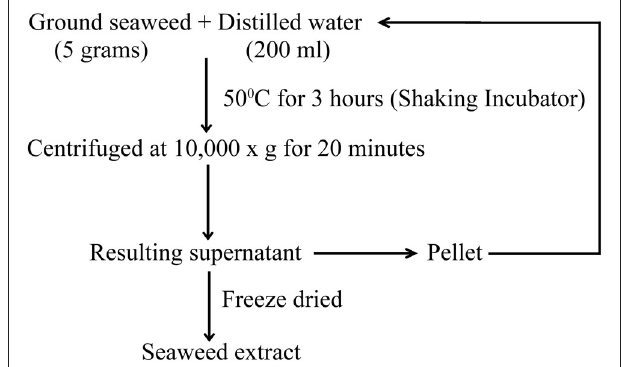
FIGURE 1 | The procedure for the extraction of red seaweed water